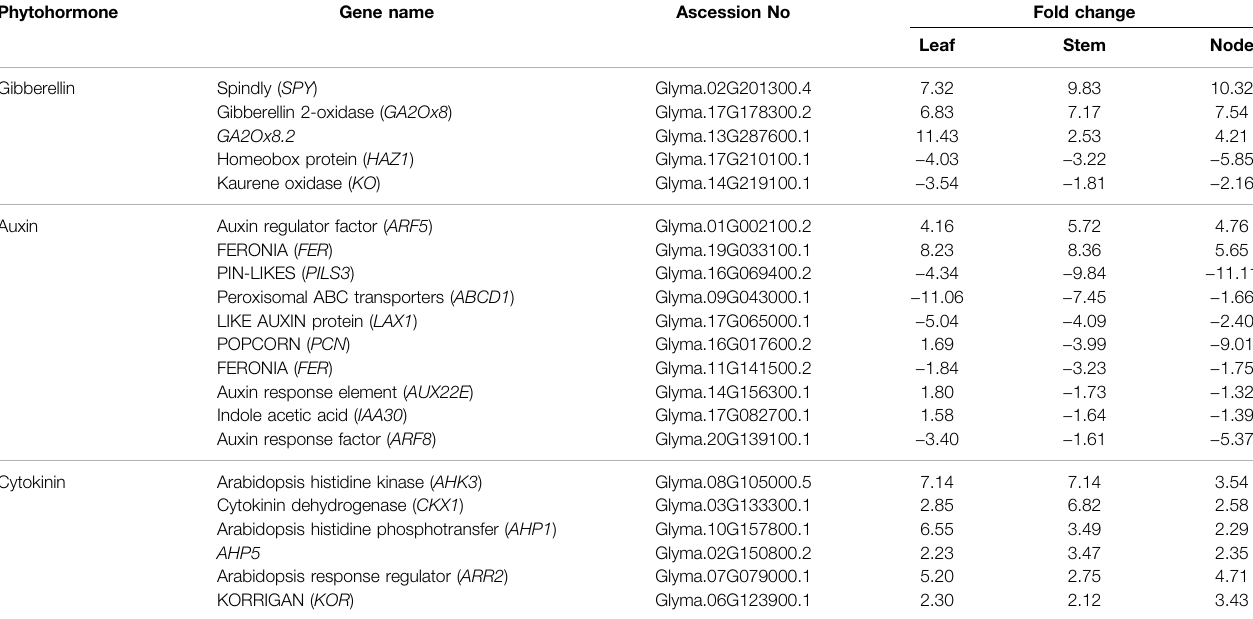
TABLE 3 | Signi fi cantly differentially expressed gene response to phytohormones in cultivar types with respect to weedy types. Phytohormone Gene